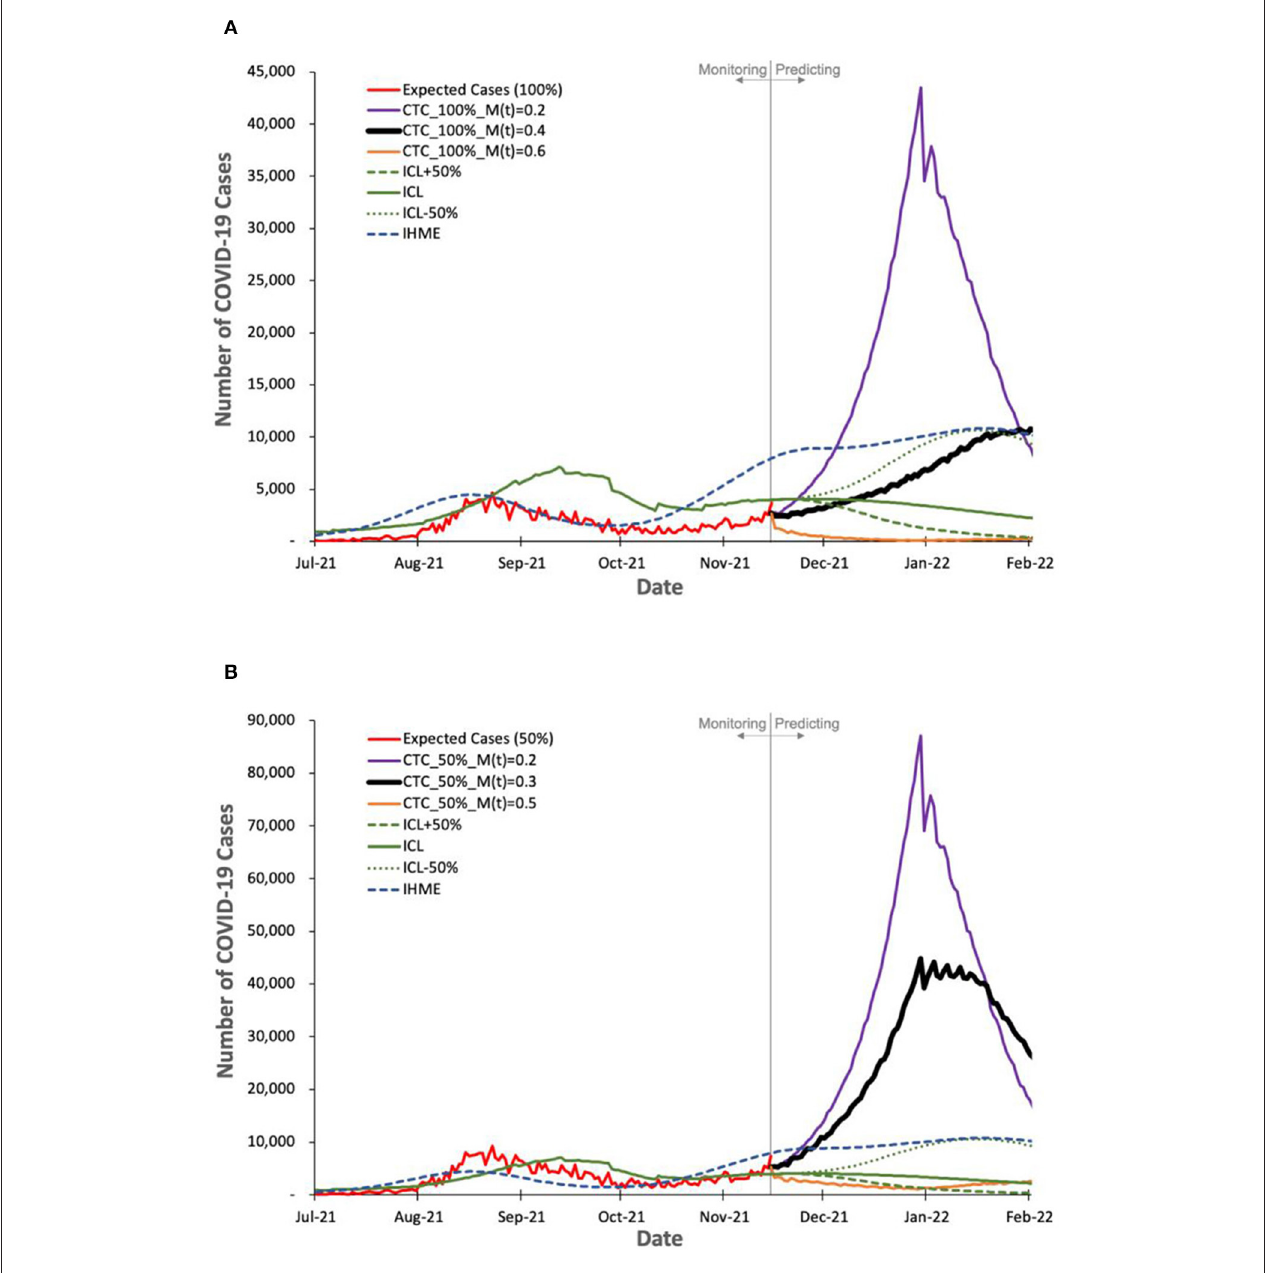
FIGURE 5 | Observed and predicted number of COVID-19 cases by our model and other two state-of-the-art models, ICL and IHME. For COVIDHunter, we use CTC environmental condition approaches with two certainty rate levels of (A) 100% and (B) 50%. We show the prediction of COVIDHunter using three mitigation coefficient, M ( t ) , values, each of which is applied from 20 November to 20 December 2021. The predicted plot in a bold black line represents the situation when the mitigation measures applied before the prediction period remain the same.